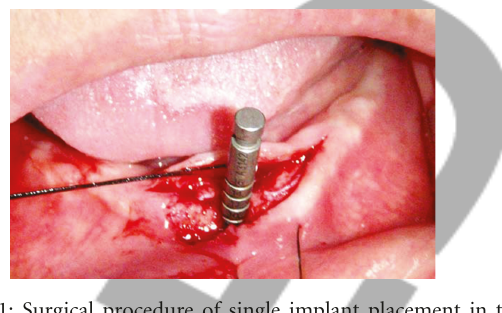
Figure 1: Surgical procedure of single implant placement in the mandibular